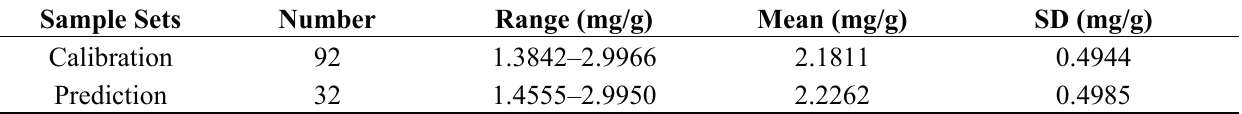
Table 1. Statistics analysis of measured samples of the calibration set and the prediction